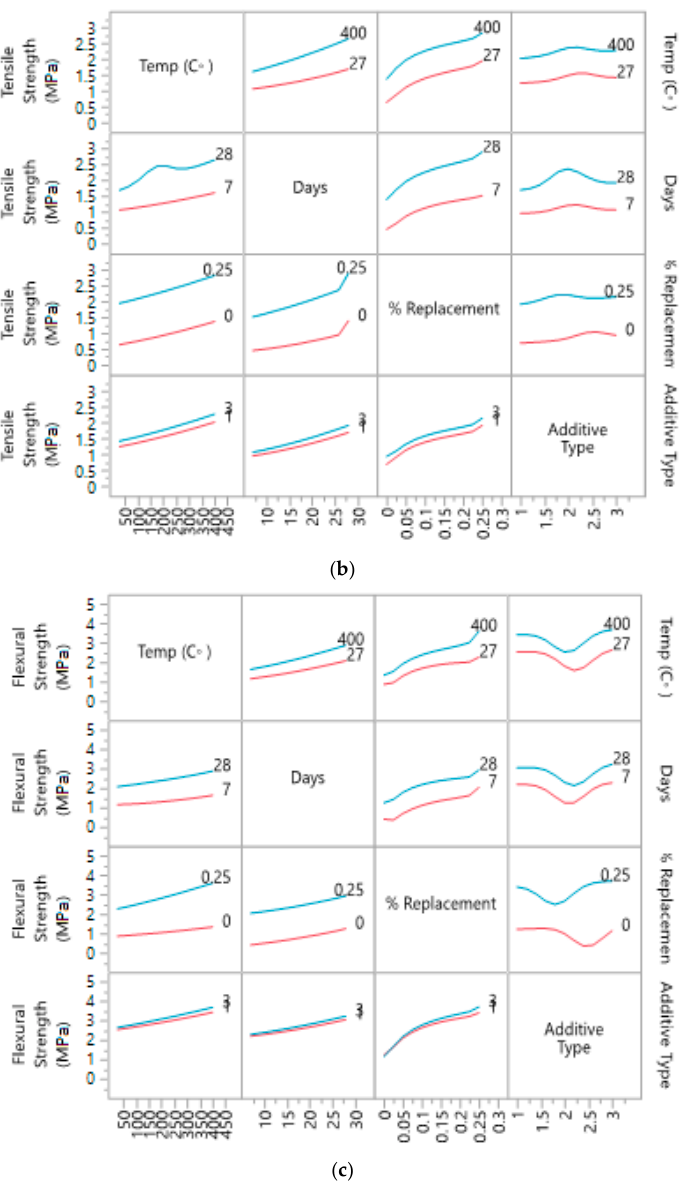
Figure 9. Interaction profile for ranges of: ( a ) compressive strength; ( b ) tensile strength; ( c ) flexural strength with four variables.